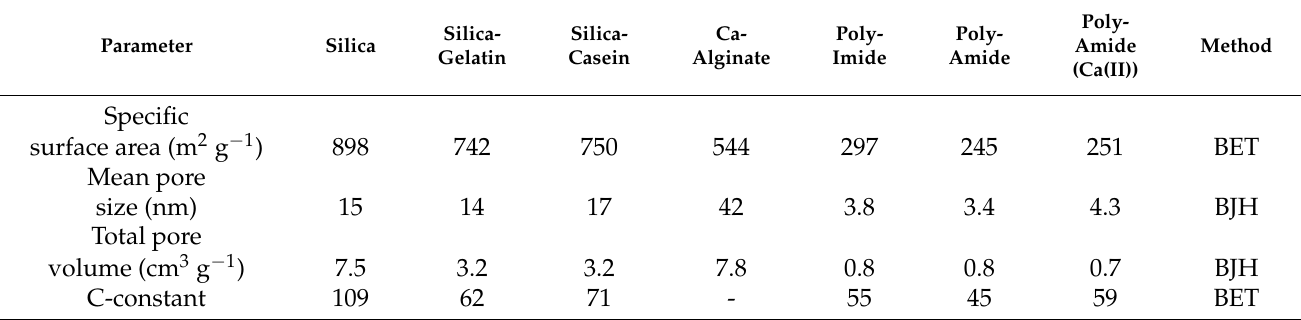
Table 1. Structural parameters derived from N 2 gas adsorption-desorption porosimetry data.